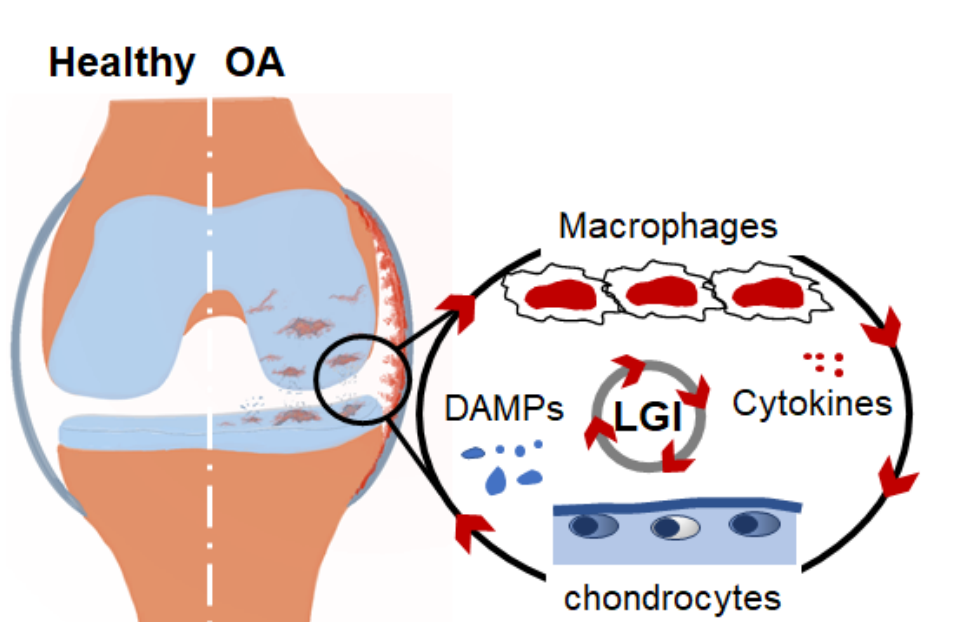
Figure 1. Schematic representation of inflammation cycle in the OA joint. Cartilage damage tissue and tears, crystals, endogenous molecules from apoptotic chondrocytes, and plasma proteins from vascular leak act as DAMPs which trigger local LGI in the joint, thus promoting the production of proteolytic enzymes. Continual release of DAMPs in the joint leads to chronic activation of innate immune cells, including macrophages, thus amplifying a vicious inflammation cycle leading to cartilage degeneration.